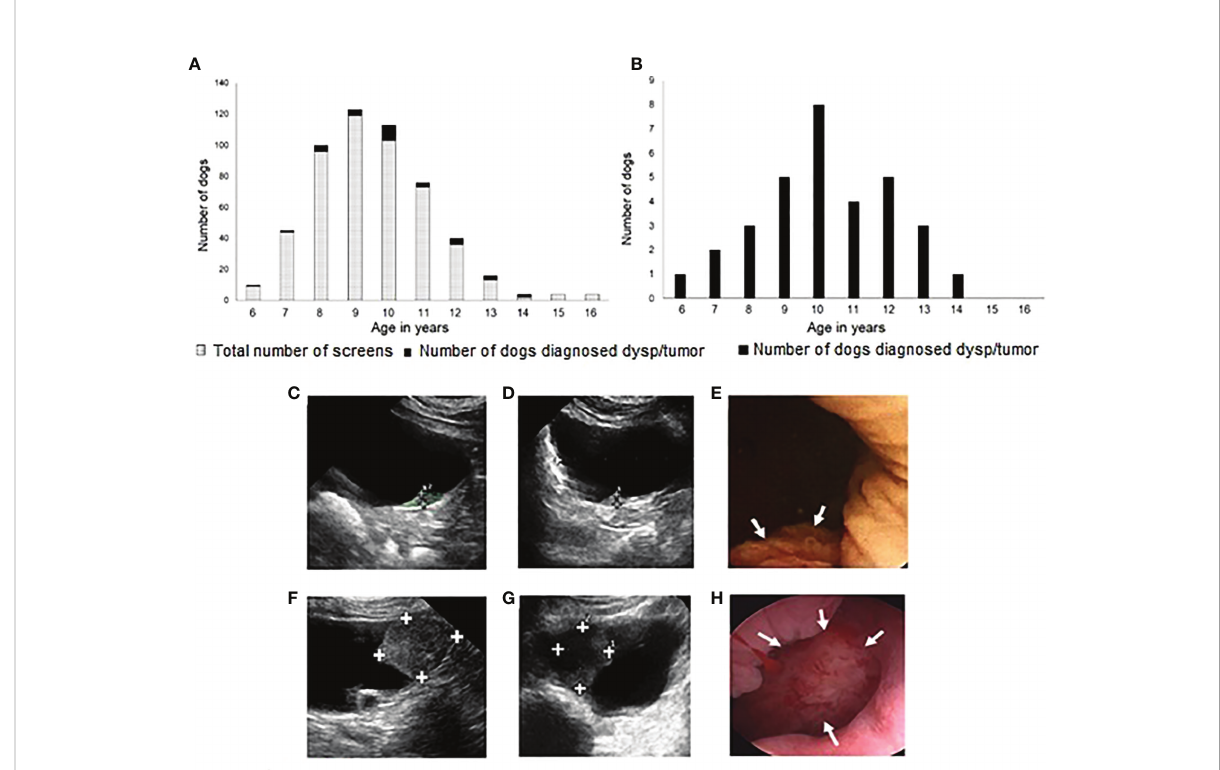
FIGURE 2 Screening history, ages of dogs screened, ages at diagnosis of bladder neoplasia, and examples of tumors detected. In (A) , each bar represents the number of screenings performed at each dog age during 3 years of screening. The number of dogs (Scottish Terriers, STs) diagnosed with dysplasia (dysp) or neoplasia are represented in the solid black sections at the top of each bar. Cancer was detected at the fi rst screening visit in 13 dogs, and at later visits in 19 dogs. In (B) , the number of dogs diagnosed with dysplasia or neoplasia at each age are summarized. Ultrasound (C) , sagittal plane, (D) , transverse plane ) and cystoscopy (E) images are included of a 0.3 x 0.3 x 0.5 cm early luminal subtype invasive urothelial carcinoma (InvUC) detected through screening. A small area of mucosal proliferation was visible at cystoscopy (E , arrows ) . For comparison, images are included from a ST with later luminal subtype InvUC not detected through screening (F-H) . A 1.6 X 2.3 X 1.9 cm mass occupies most of the trigone region of the bladder in the ultrasound sagittal plane (F) , transverse plane (G) , and cystoscopy (H , arrows )